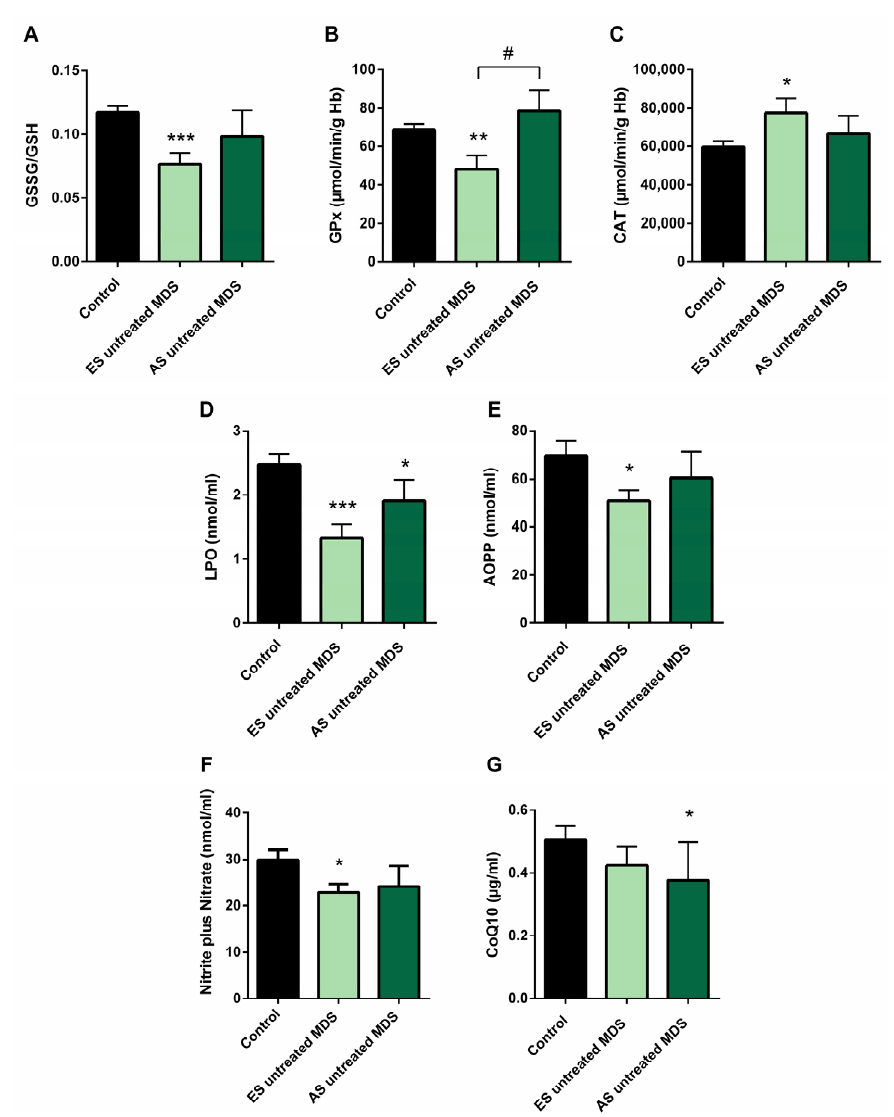
Figure 3. Oxidative stress biomarkers during myelodysplastic syndrome (MDS) progression. ( A ) erythrocyte GSSG·GSH − 1 ratio; ( B ) glutathione peroxidase (GPx) and ( C ) catalase (CAT) activities; ( D ) lipid peroxidation (LPO); ( E ) advanced oxidation protein products (AOPP); ( F ) nitrite plus nitrate; and ( G ) CoQ10 levels in plasma in early stage (ES untreated MDS) vs. advanced stage of untreated MDS patients (AS untreated MDS). Data are presented as mean ± SEM. * p < 0.05, ** p < 0.01, *** p < 0.001 vs. control; # p < 0.05 vs. ES untreated MDS group.